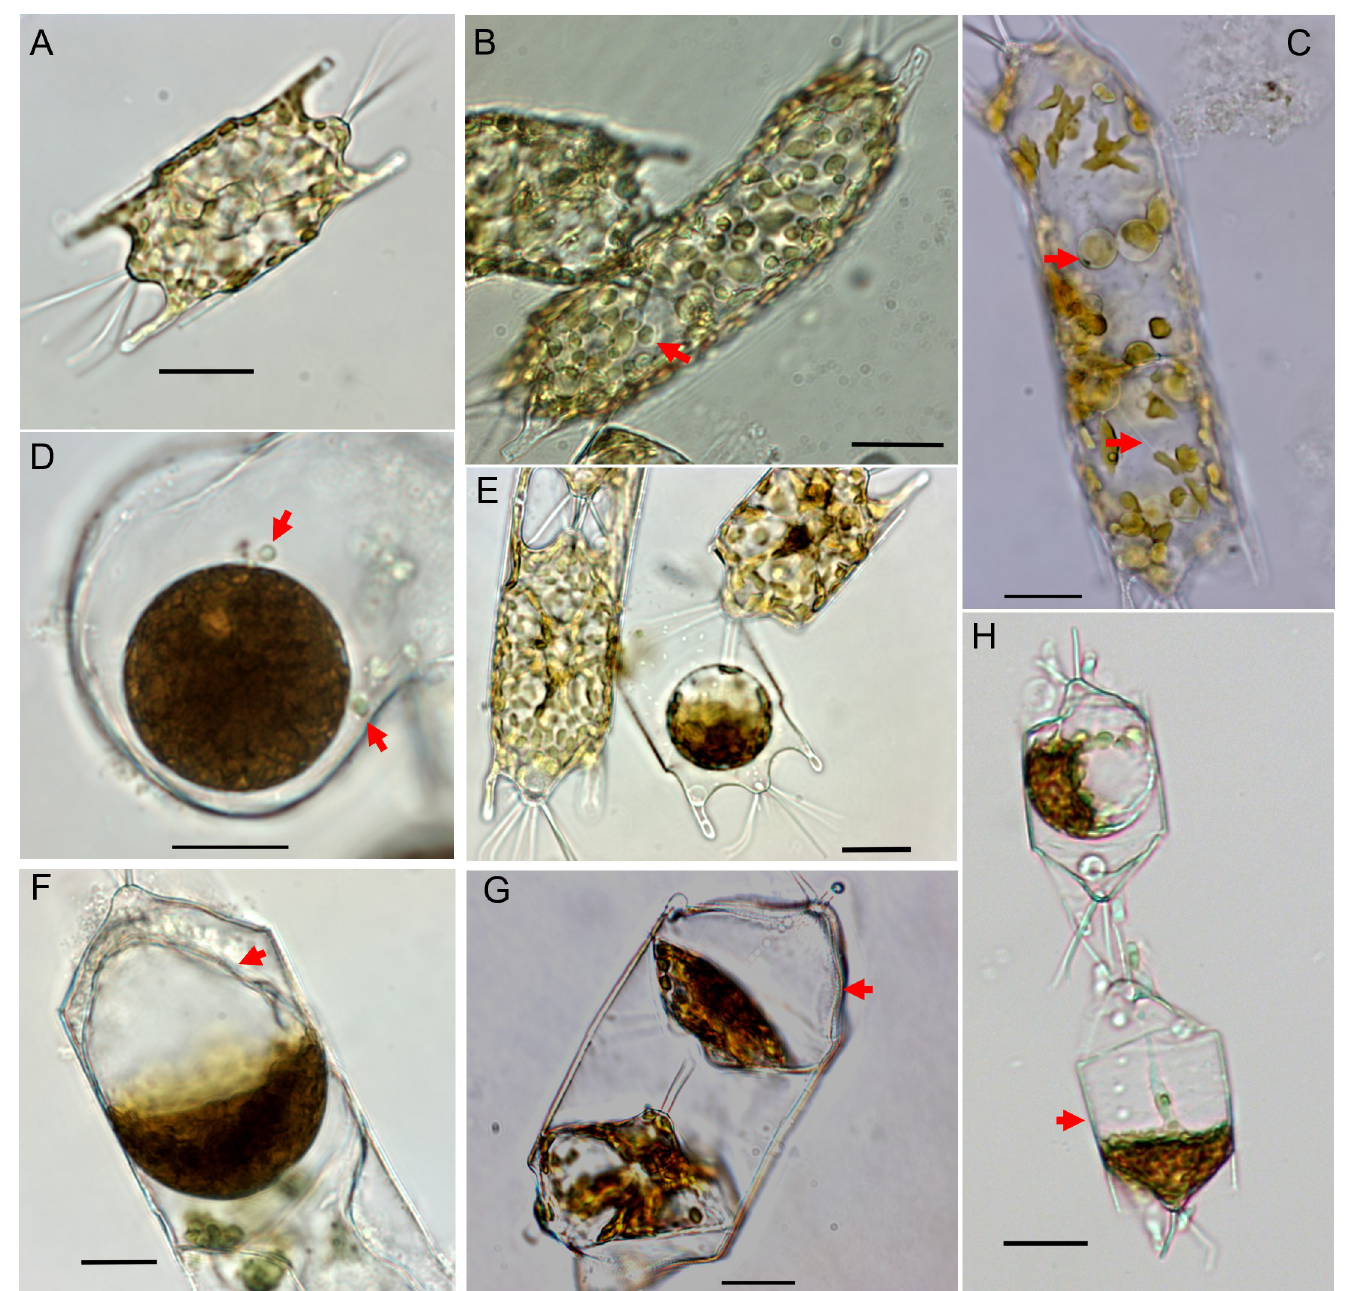
Fig 1. Reproductive stages and the auxospores of Odontella sp. diatom. (A) Vegetative Odontella cell. (B) Spermatogonium with primary spermatocytes (arrow) (C) Spermatocytes (arrow) and sperm cell (arrow pointing to its tail) inside the spermatogonium. See S1 Video displaying the movement of the tail. (D-E) Oogonium, the two arrows point to sperms attached to the egg in D. (F-H) Auxospores, arrow points to the properizonium. Black scale bar is 20 μ m. temperature to exponential phase (2 days). LB broth only and LB with tryptophan were used as negative controls in the experiment. An aliquot of 500 μ L was fixed with 1% paraformalde- hyde for bacterial counting using imaging flow cytometry. The remaining culture was centri- fuged at 3000g for 5 min, and the supernatant was taken to measure extracellular IAA concentration through reaction with Salkowski reagent. A standard curve was created using